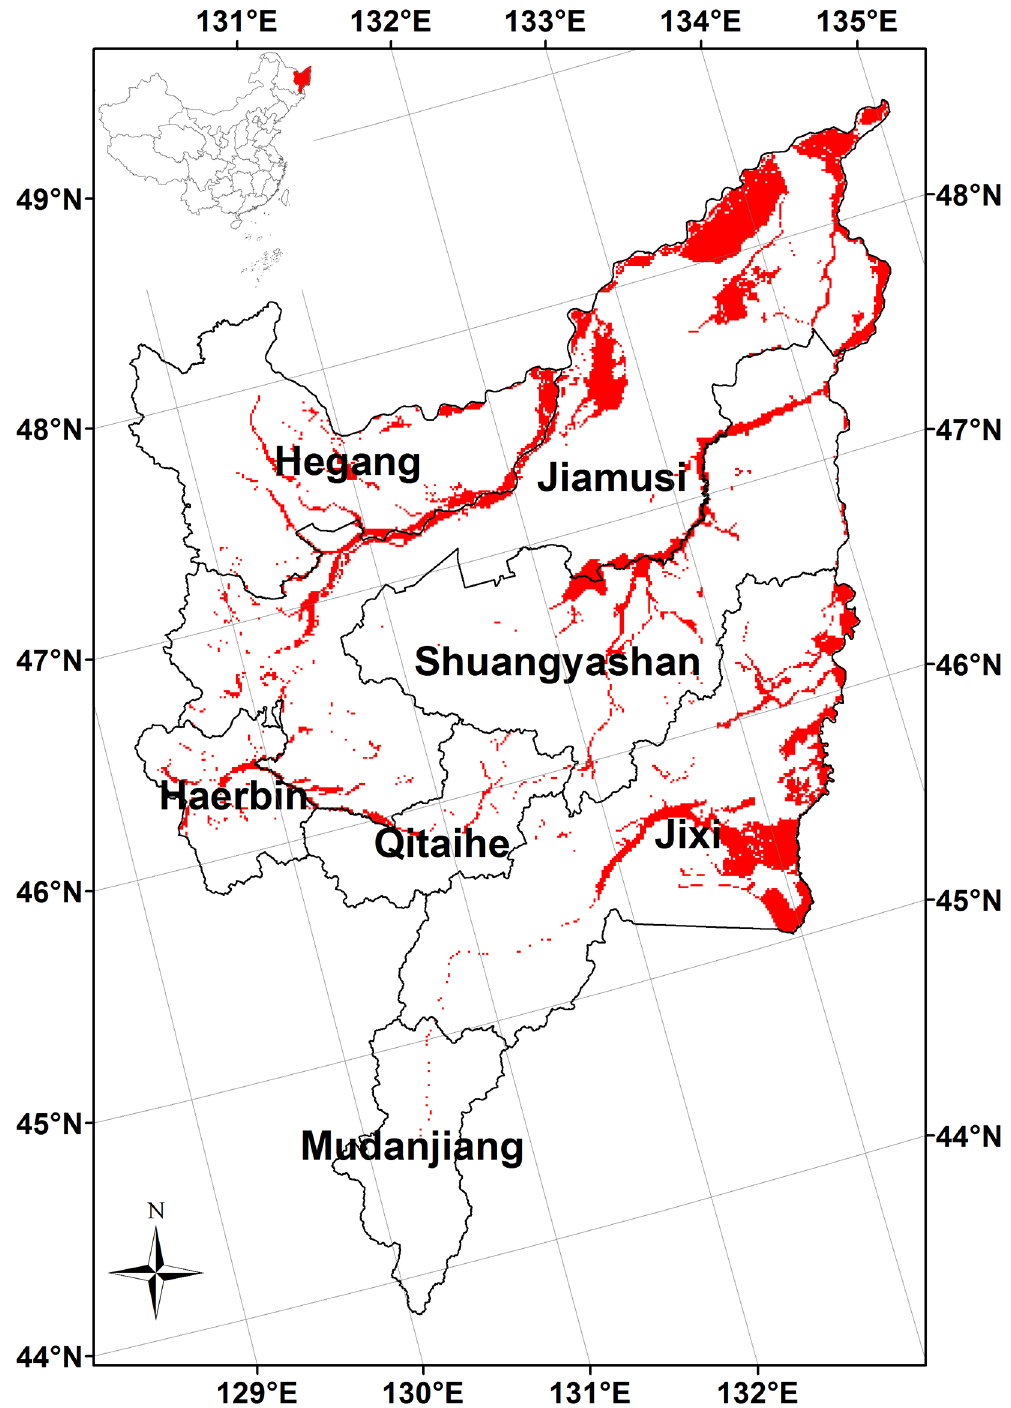
Fig 1. Spatial distribution of the wetland in the Sanjiang Plain. Map constructed in ESRI ArcMAP 10.1. Base image of the boundaries is obtained from the Open Platform of Ministry of Civil Affairs of the People ’ s Republic of China [48]. The wetland distribution is from